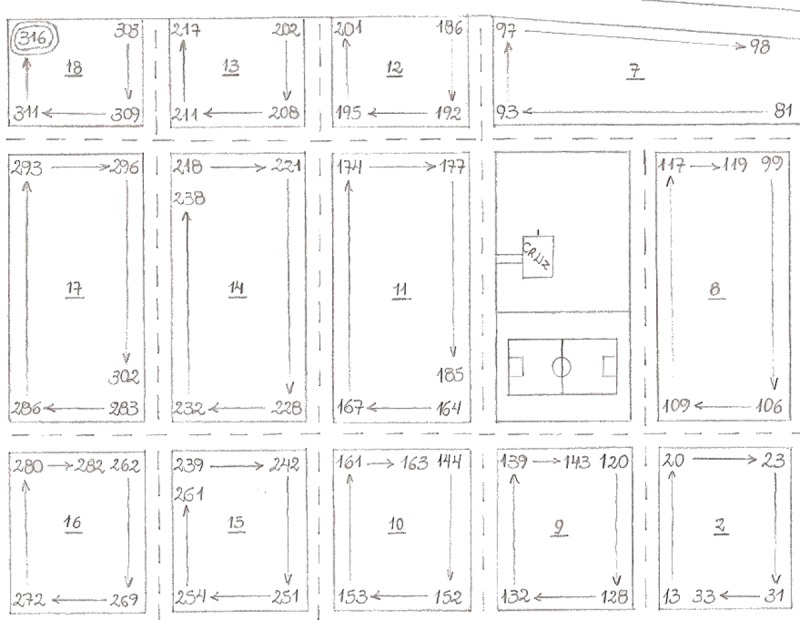
Example of a paper map used in vector surveillance under the current practice.The numbers displayed on each block are the last three digits of the house code, with arrows indicating their ascending order. For example, a block with ‘1 → 12’ indicates that houses with unicodes ending in one through 12 are on that block. Street names and other identifying information have been removed.